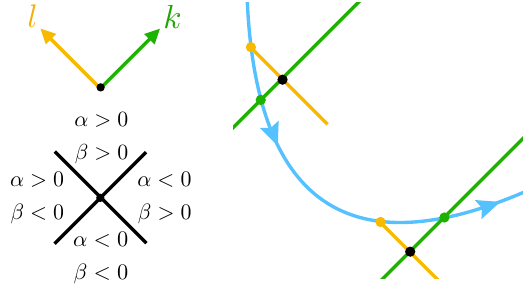
0 (blue l ( (cid:27) 0 ( (cid:28) )) (cid:0)